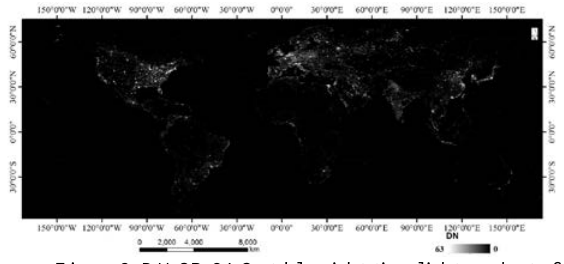
Figure 2. DMSP-OLS stable night-time light product of